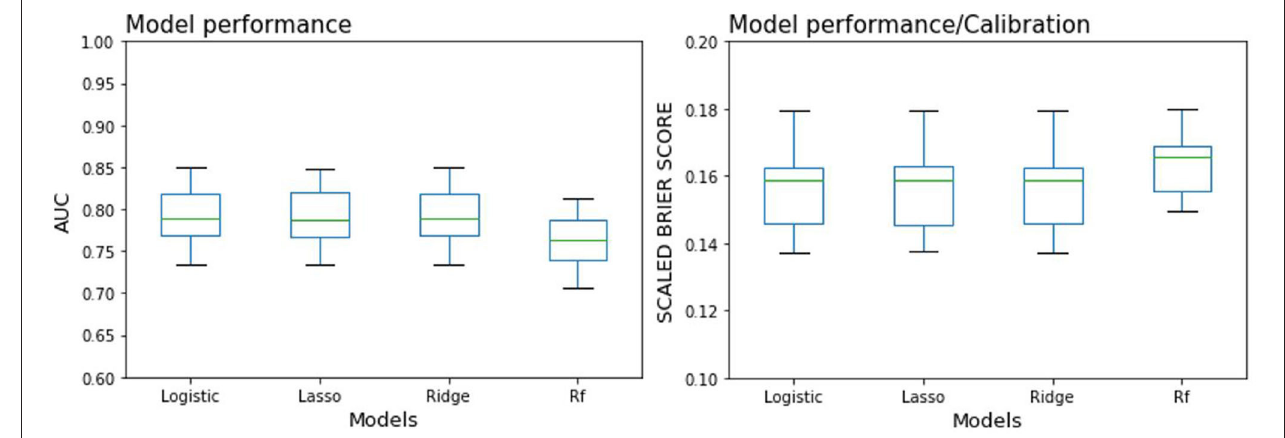
FIGURE 3 | Boxplot of 100 resampling results for each prediction model (see median results in Table 2 ). Logistic, Logistic regression model; Rf, Random forest model. Left: Area under the curve (AUC). Right: Scaled Brier score, with values below zero indicating a model performance/calibration inferior to that of a chance prediction model applied to the validation